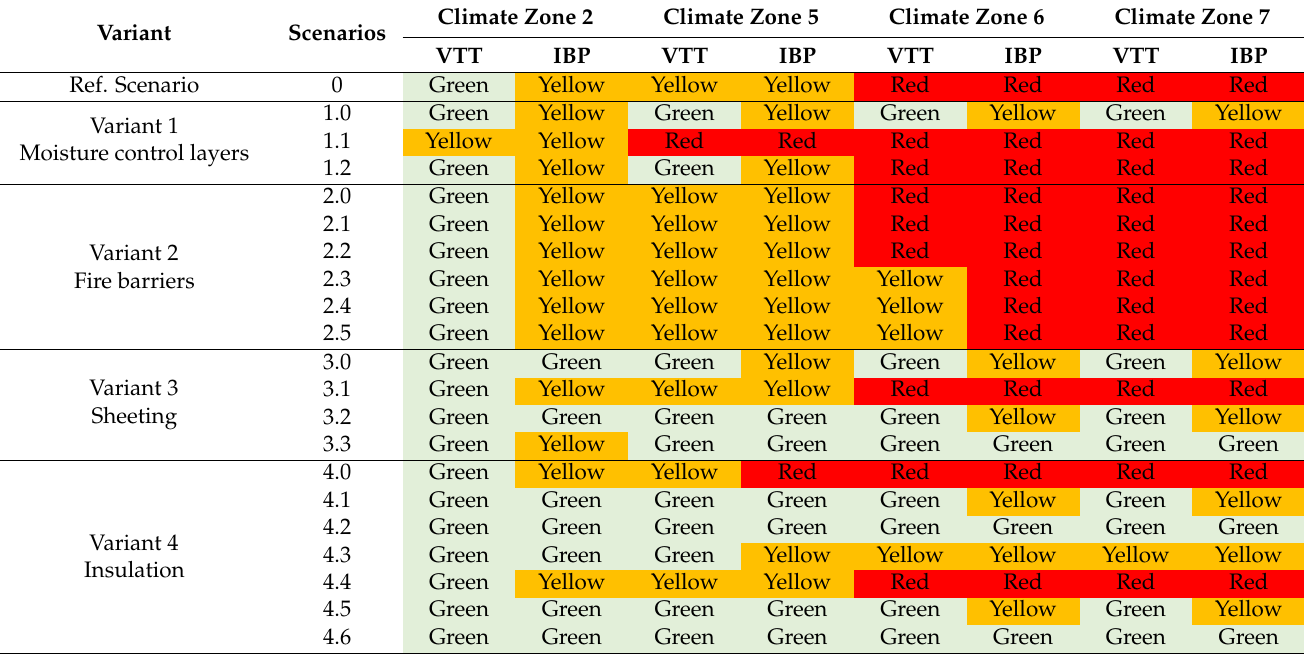
Table 8. Results of the mould growth risk assessment for various timber-framed wall configurations.